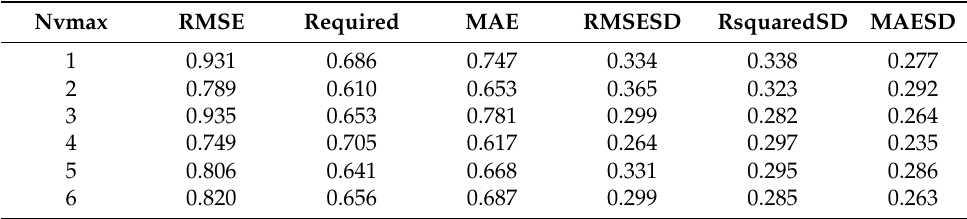
Table 3. Results of the tenfold cross-validation for the optimal Ricker-E model. Nvmax RMSE Required MAE